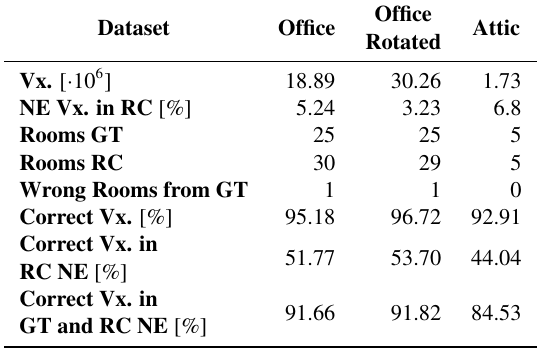
(a) All cases as listed in Table 4.